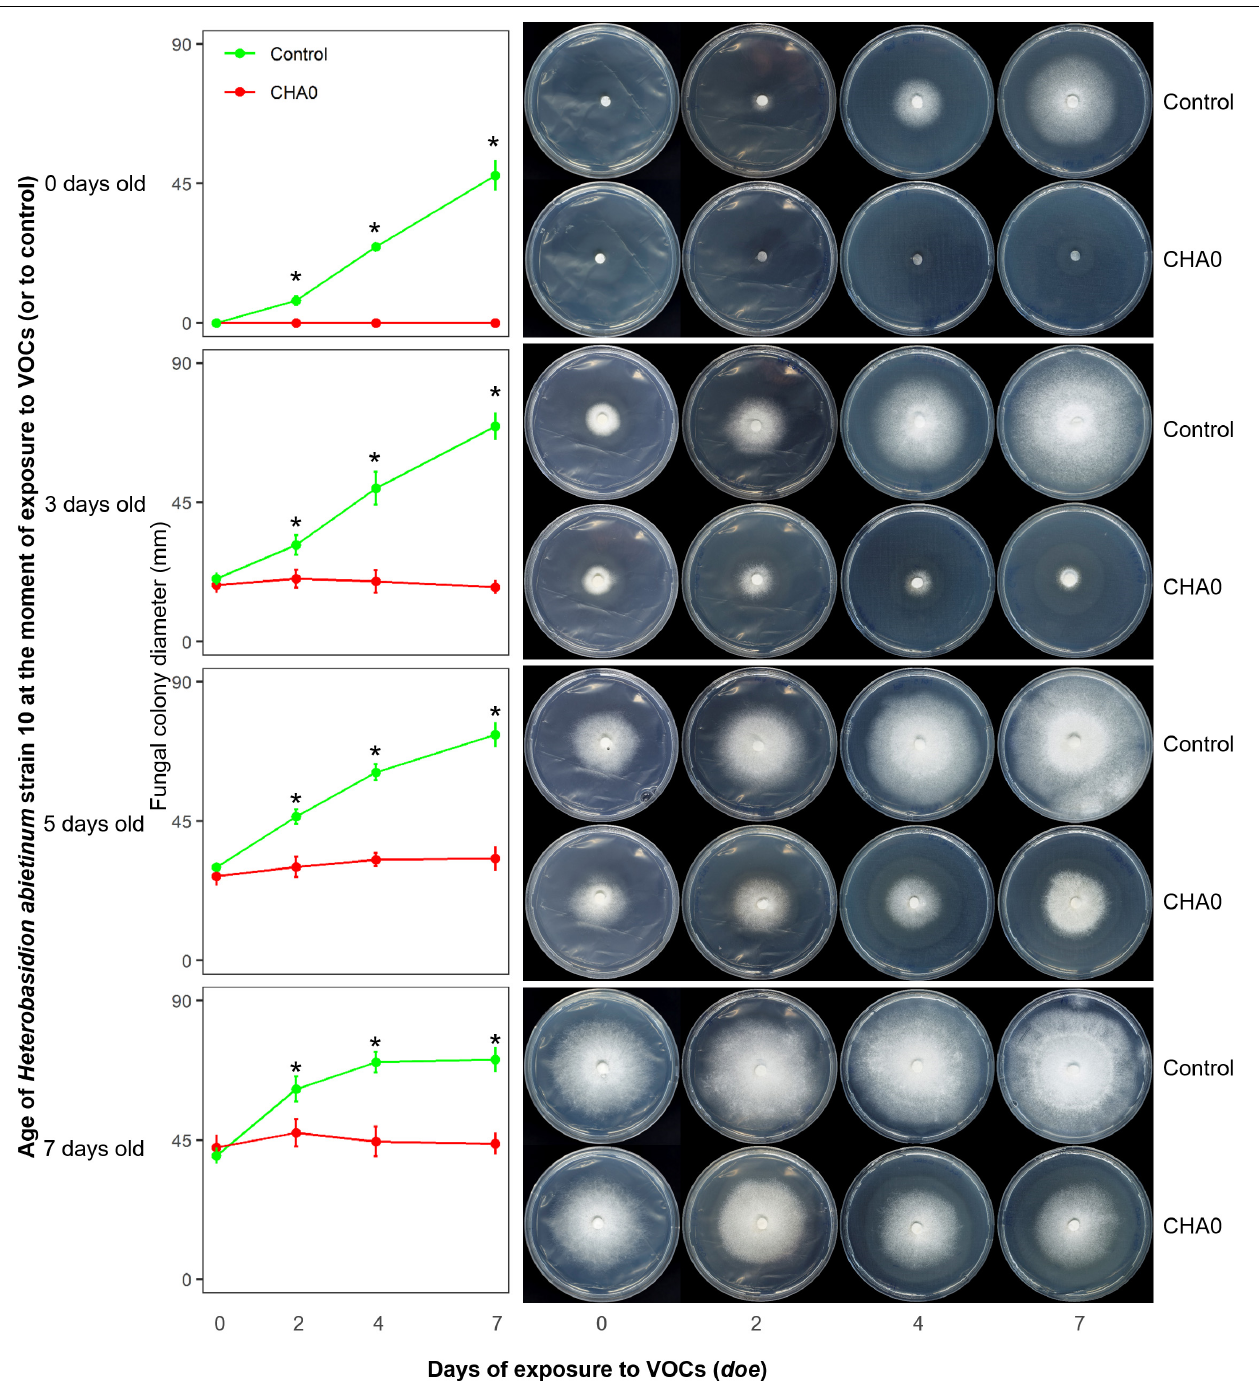
FIGURE 2 | Experiment C. Effect of volatile organic compounds (VOCs) emitted by Pseudomonas protegens CHA0 on differently aged mycelia of Heterobasidion abietinum strain 10. The photos show colonies of H. abietinum strain 10 grown on potato dextrose agar (PDA) and exposed to VOCs emitted by CHA0 grown on Luria-Bertani agar (LBA). Halos around the colonies were due to diffusible substances secreted by the fungus and did not contain hyphae. In the graphs, error bars are the standard error of the mean of three replicates (plates). Asterisks indicate a significant difference between VOC-exposed colonies and the control according to the LSD test ( P < 0.05). The growth of VOC-exposed colonies did not significantly differ over time (at 2, 4, and 7 days of exposure to VOCs, or doe , compared to control, i.e., 0 doe ).